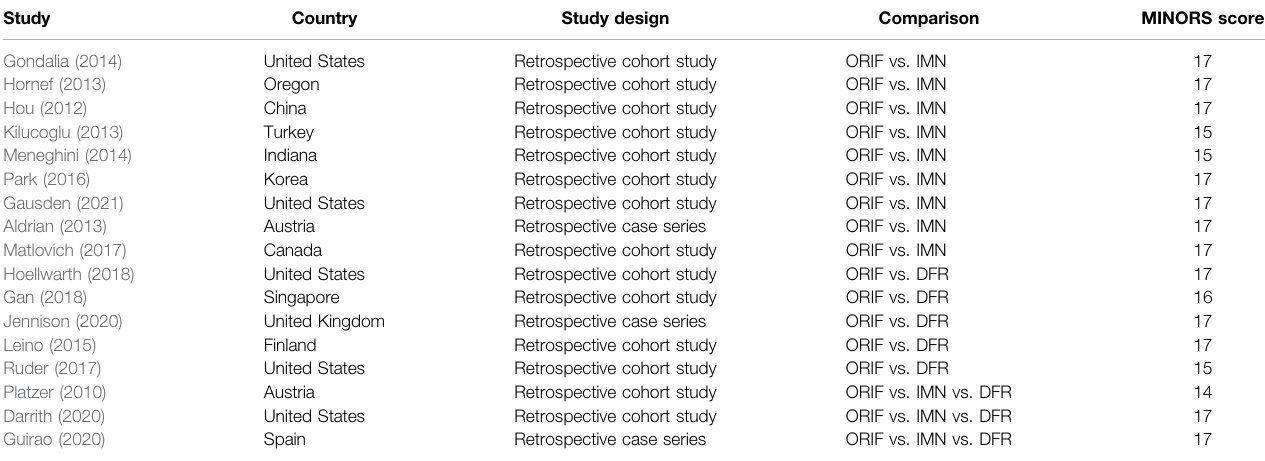
TABLE 1 | Characteristics of included studies ( n =